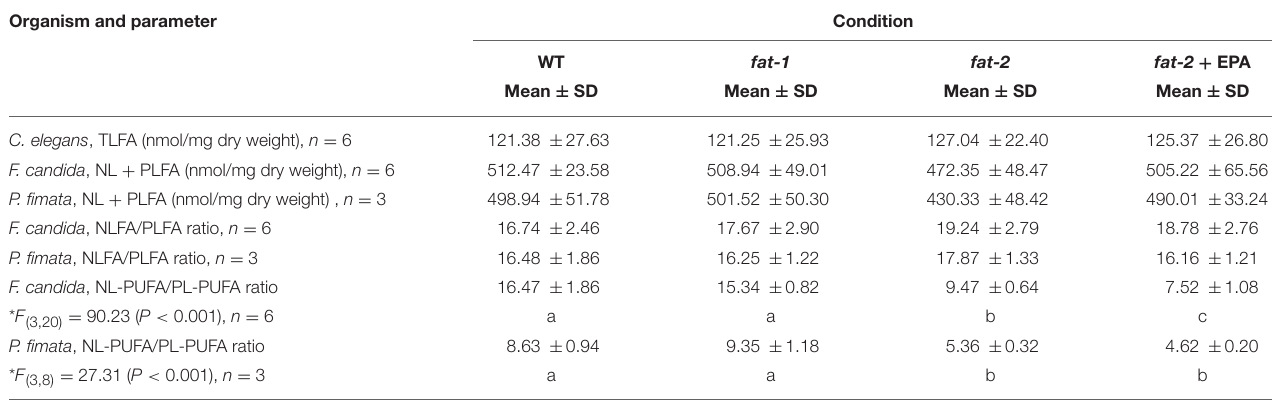
TABLE 1 | Total fatty acid content and NLFA/PLFA ratios. Organism and